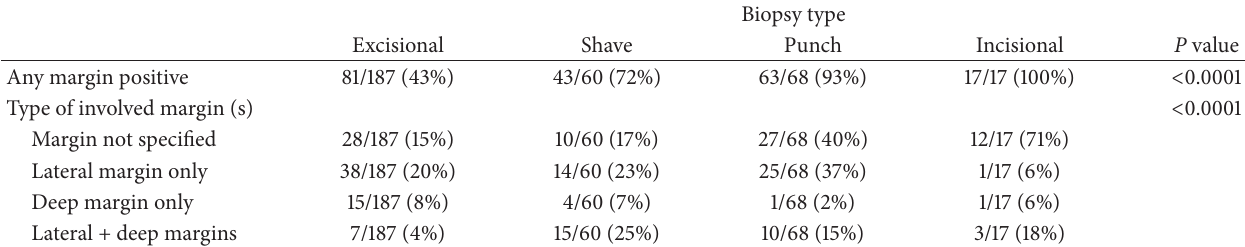
Table 2: Frequency and extent of positive margins by biopsy type.